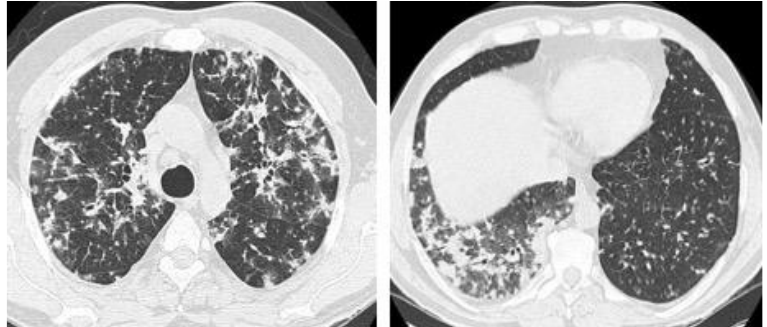
Figure 6 . Acute histoplasmosis infection. Axial CT images from upper ( left image ) and lower levels ( right image ) showing bilateral peribronchovascular consolidations and groundglass opacities, and ill-defined centriacinar nodules. ill-defined centriacinar nodules.